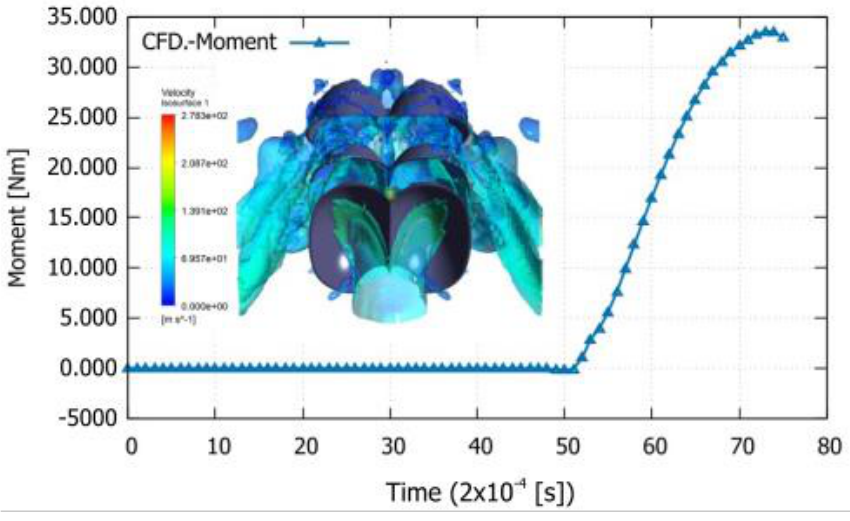
Figure 11. Moment developed for turbine.